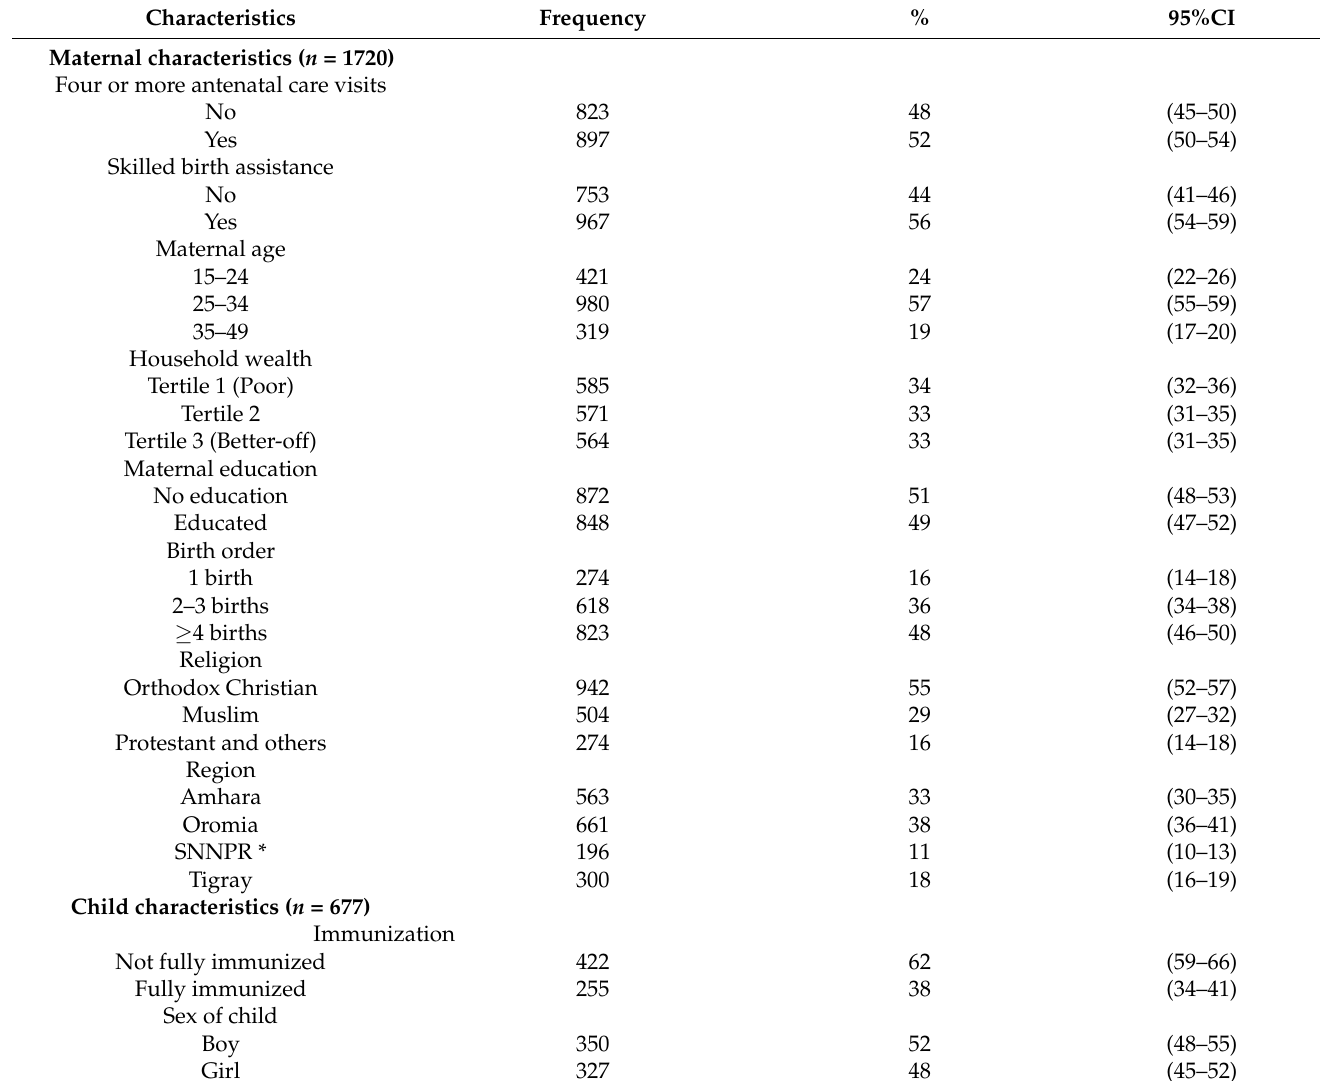
Table 1. Characteristics of study participants in four Ethiopian